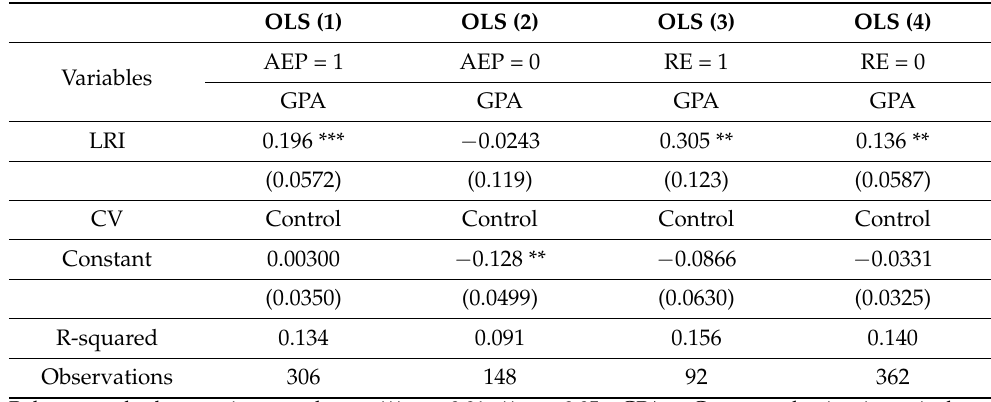
Table 6. Results of heterogeneity analysis of the effect of LRI on GPA: AEP and RE. OLS (1) OLS (2) OLS (3) OLS (4)